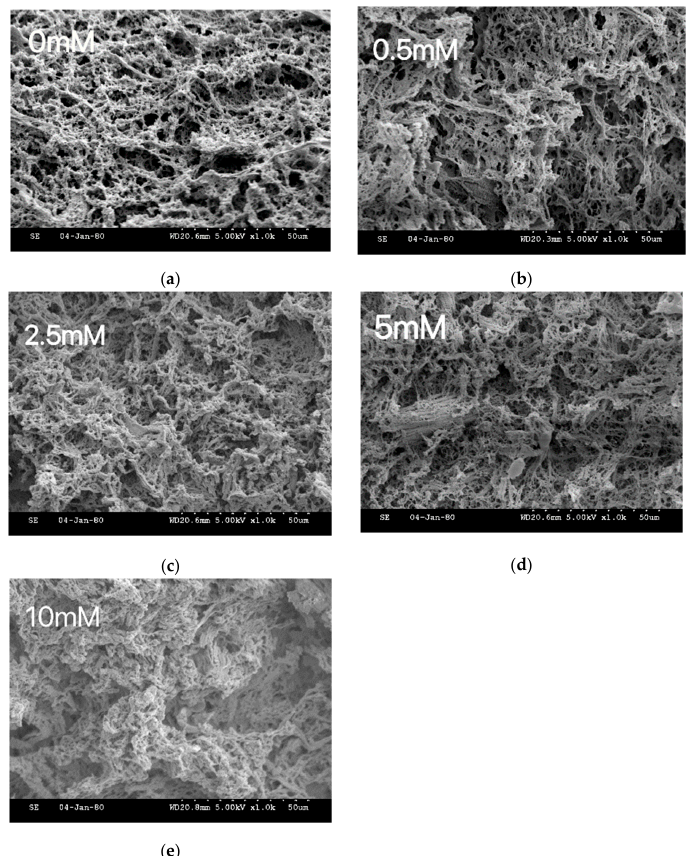
Figure 7. Gel microstructure analysis of duck myofibrillar proteins treated with malondialdehyde (MDA) concentrations of 0 mmol/L ( a ), 0.5 mmol/L ( b ), 2.5 mmol/L ( c ), 5.0 mmol/L ( d ), and 10.0 mmol/L ( e ).